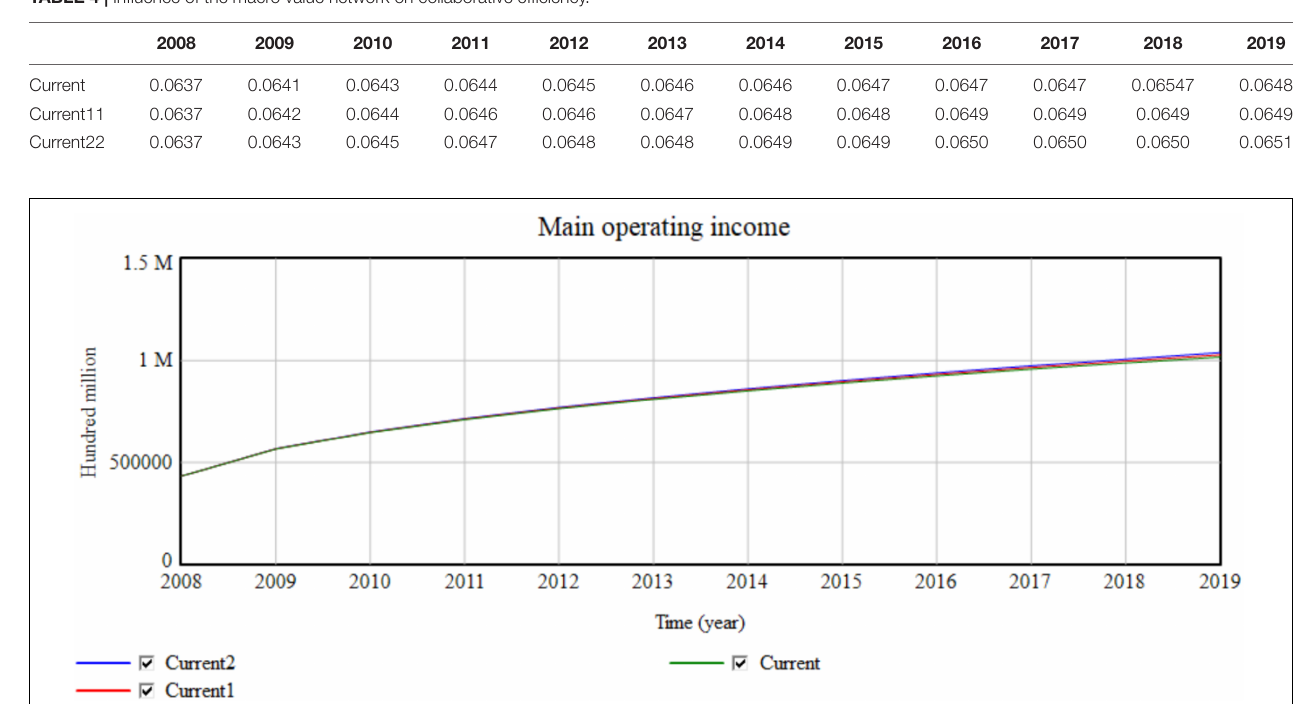
TABLE 4 | Influence of the macro value network on collaborative efficiency.